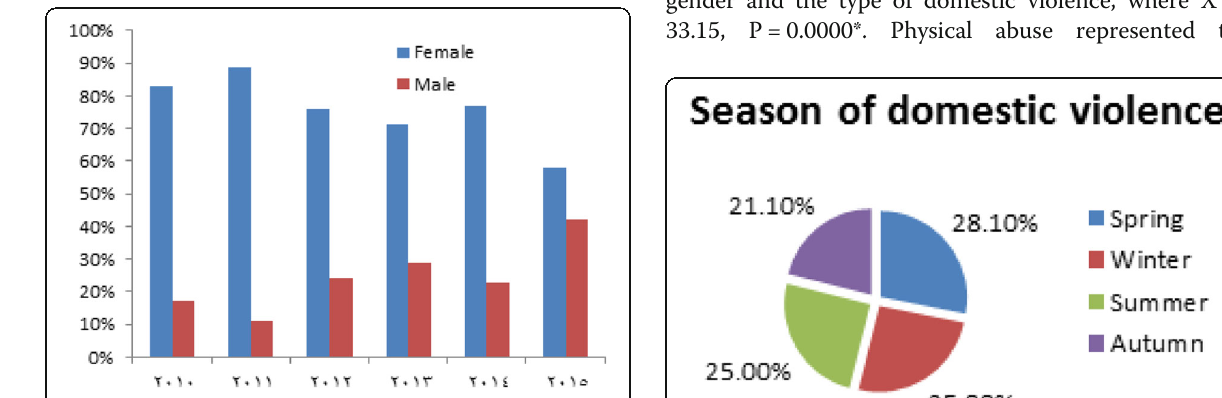
Fig. 1 Distribution of domestic violence victims according to gender over the studied years